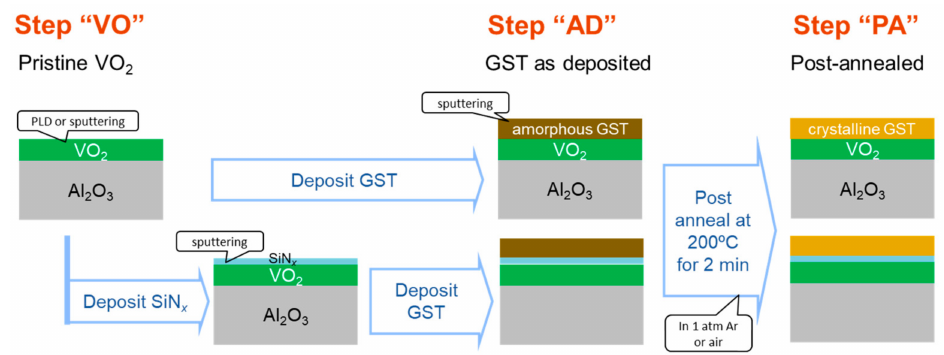
Figure 1. Preparation processes of GST / VO 2 and GST / SiN x / VO 2 multilayered